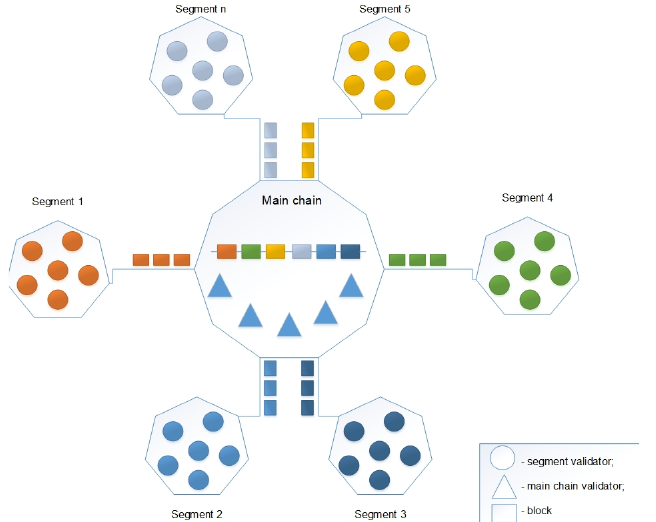
Figure 2. Multi-chain